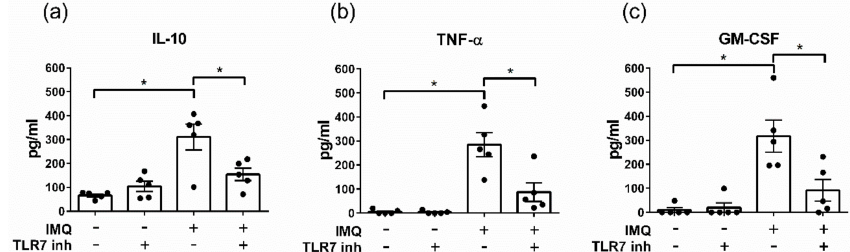
Figure 3. Ex vivo stimulation of human aortic valve tissue with the TLR7 agonist IMQ alters cytokine secretion. Human stenotic aortic valve tissue was stimulated ex vivo with the TLR7 ligand imiquimod (IMQ; 12.5 µ g / mL). Levels of ( a ) IL-10, ( b ) TNF- α , and ( c ) GMCSF were significantly increased in the culture medium after 20 h. The e ff ects of IMQ were significantly attenuated by the TLR7 antagonist ODN 20958 (5 µ M). Data are presented as mean ± SEM. 1-way RM ANOVA with Holm-Sidak post-hoc test, * p <